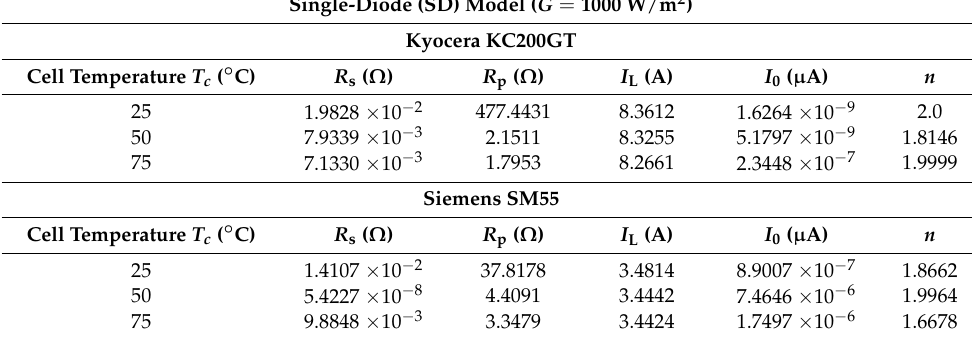
Table 9. DD model PV cell parameters at different cell temperatures (25, 50 and 75 ◦ C ) and fixed solar irradiance ( G = 1000 W/m 2 ), extracted by considering an individual PV cell from both the Kyocera KC200GT and Siemens SM55 Solar